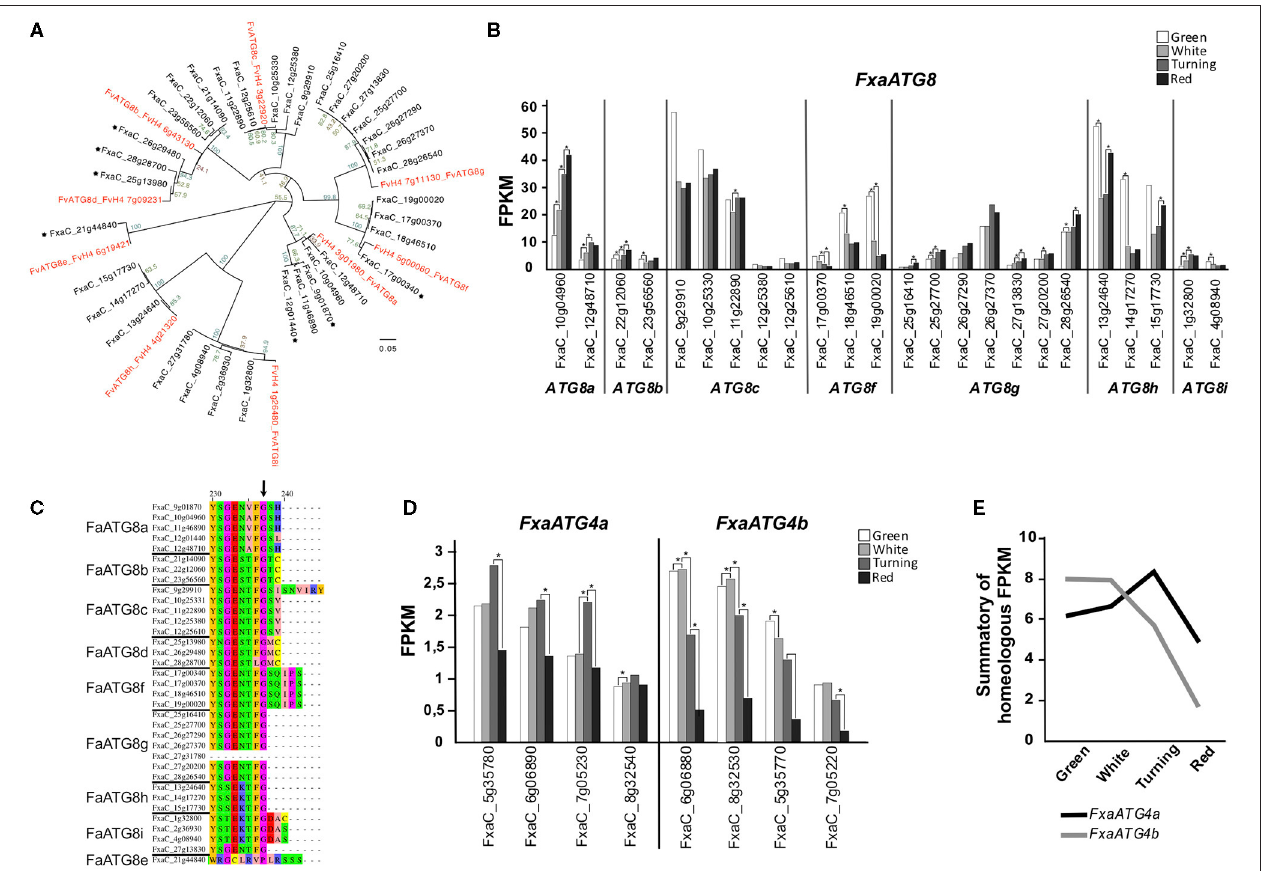
FIGURE 2 | Analysis of FaATG8 and FaATG4. (A) Phylogenetic tree of F. vesca and F. x ananassa ATG8 genes. Nucleotide sequences were aligned by MAFFT and the tree was generated by the neighbor-joining method and displayed using FigTree. Asterisks mark genes with < 0,5 FPKM expression values in all tissue tested (achenes, receptacle, leaves, and roots). (B) Representation of Fa ATG8 genes expressed at least 1 FPKM in any stage of the process of receptacle ripening. (C) Alignment of C ′ -terminus end of the different FaATG8 homoeologs. Arrow indicates the conserved Glycine essential for lipidation. (D) Representation of FaATG4 expression during strawberry ripening. (E) Expression trend of FaATG4a and FaATG4b homoeologs during ripening. Data shown in (B–E) were extracted from the RNAseq dataset generated by Sánchez-Sevilla et al. (2017). Statistical significance between one stage and the following stage it is indicated with an asterisk. Statistical analysis was performed with the false discovery rate (FDR) method after Benjamini-Hochberg correction for multiple-testing. Complete statistical analysis can be found in Supplementary Table 2 . Alignment that generated phylogenetic tree (2A) can be found in Supplementary Data Sheet 1